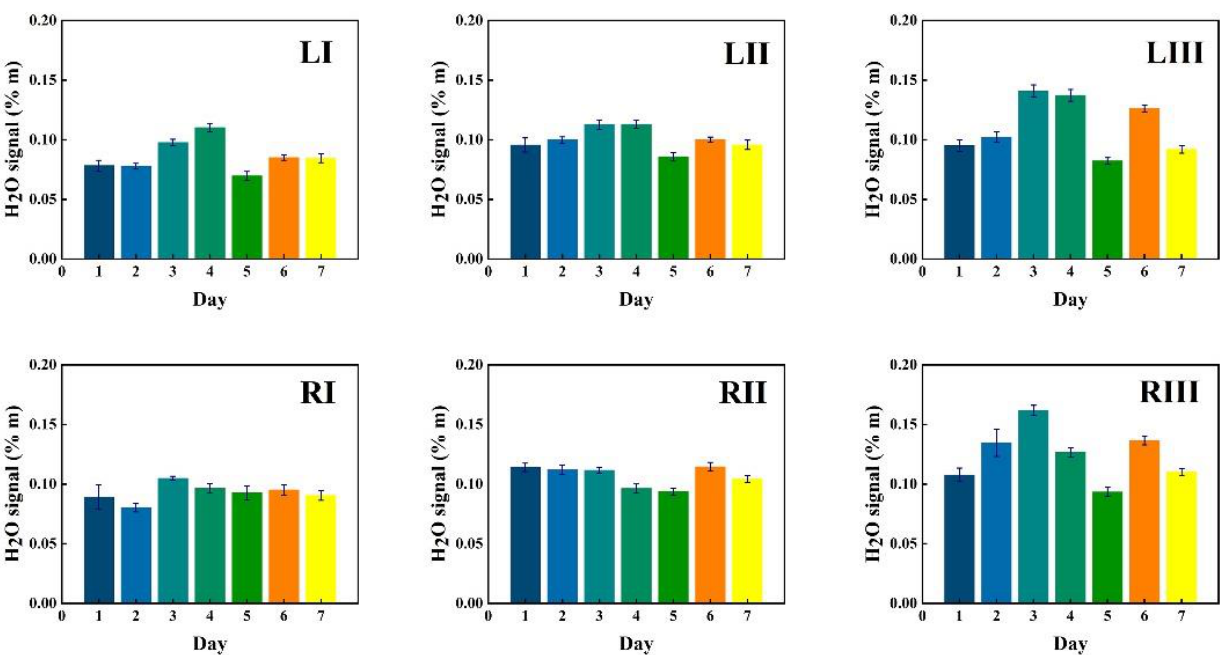
Figure 6. The changes of measured water vapor signal at different locations for volunteer 1 during one week, together with the standard deviation.